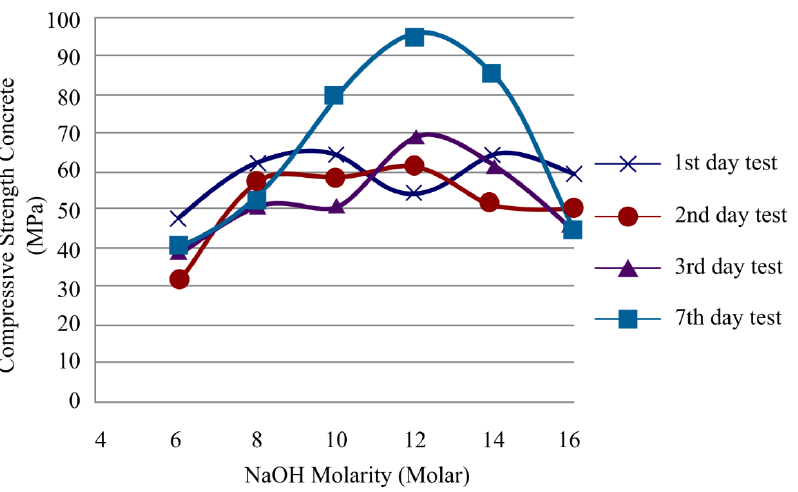
Figure 17. Compressive strength of all mixtures with different molarities and curing days [142].